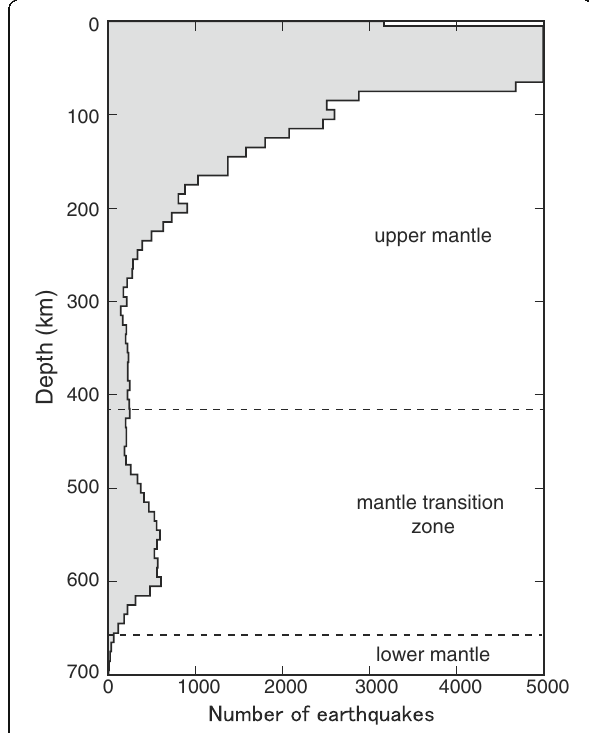
Fig. 1 Focal depth distribution of global seismicity for the period of 1960 – 2007. The shallower peak is truncated to show the deeper peak in